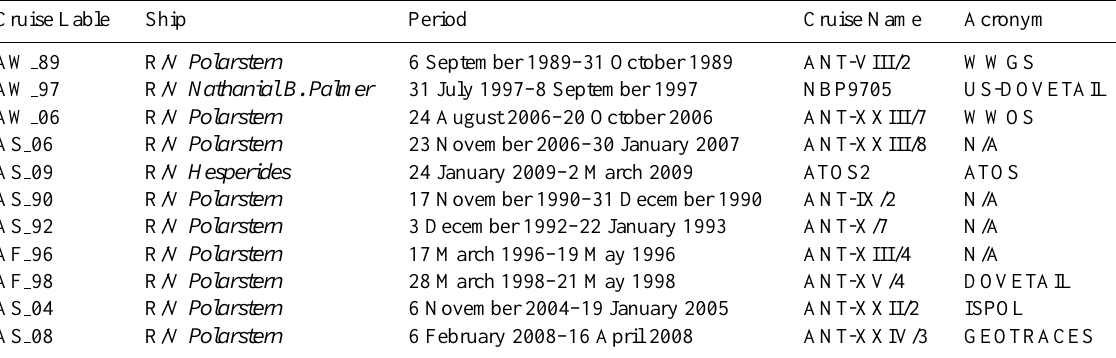
Table 1. Cruise details, separated in the cruises analysed (upper five) and used as supplement (lower six). For simplicity, the official cruise name was converted to a more suitable (season year) nomenclature. AS = austral summer, AF = austral fall, AW = austral winter. WWGS = Winter Weddell Gyre Study (Augstein et al., 1991), DOVETAIL = Deep Ocean VEntilation Through Antarctic Intermediate Layers (Muench and Hellmer, 2002), ISPOL = Ice Station POLarstern (Hellmer et al., 2008), WWOS = Winter Weddell Outflow study (Lemke, 2009), ATOS2 was the Antarctic part of the bipolar Spanish project ATOS, standing for “Intake of Atmospheric Organic Carbon and Pollutants by the Polar